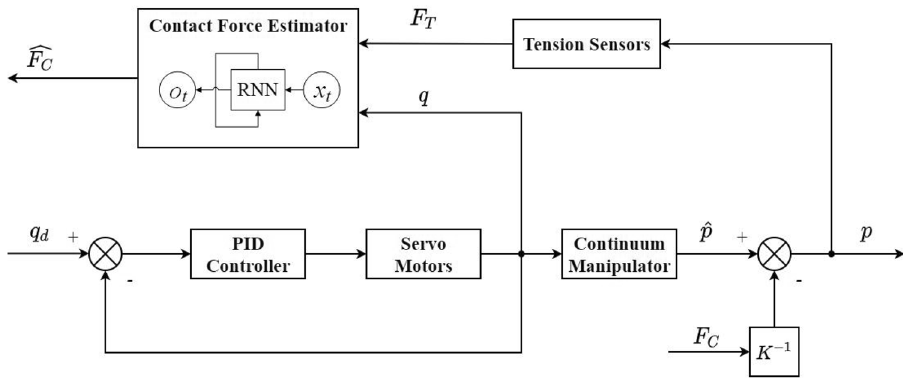
Figure 3. Design of the real-time contact force